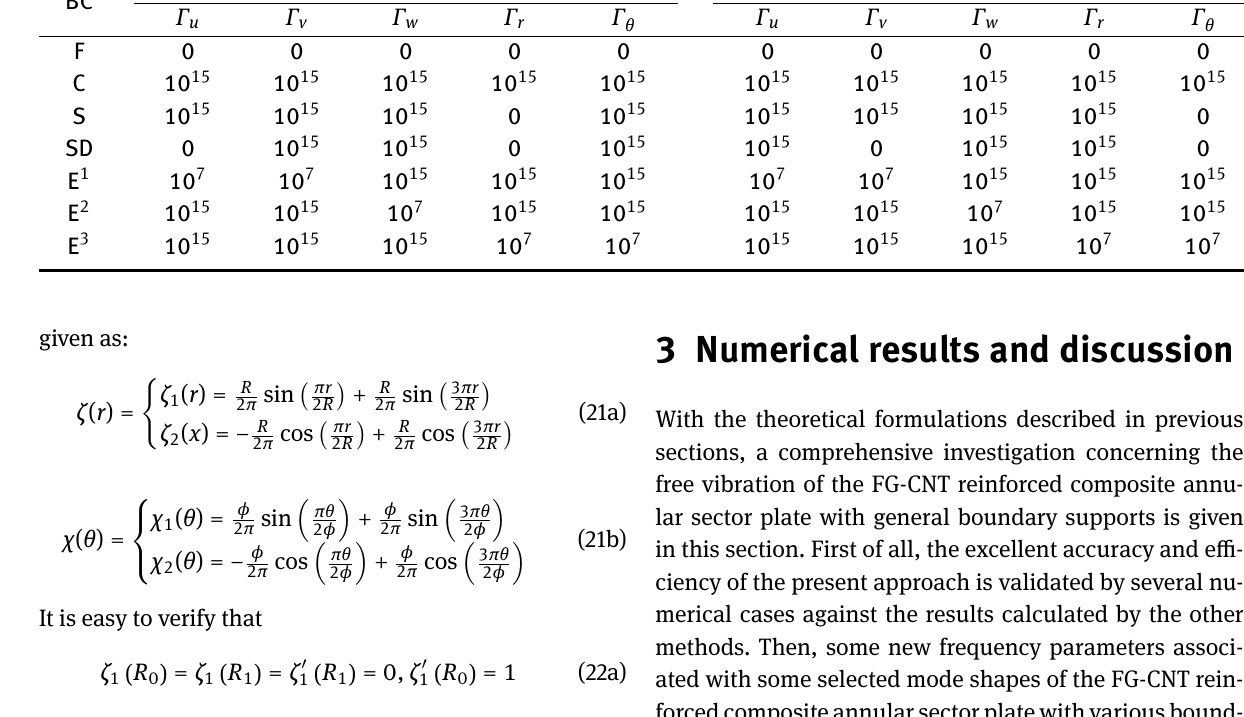
Table 1: The corresponding elastic restraint parameters for various boundary conditions x = constant θ = constant BC Γ u Γ v Γ w Γ r Γ Γ u Γ v Γ w Γ r Γ θ F